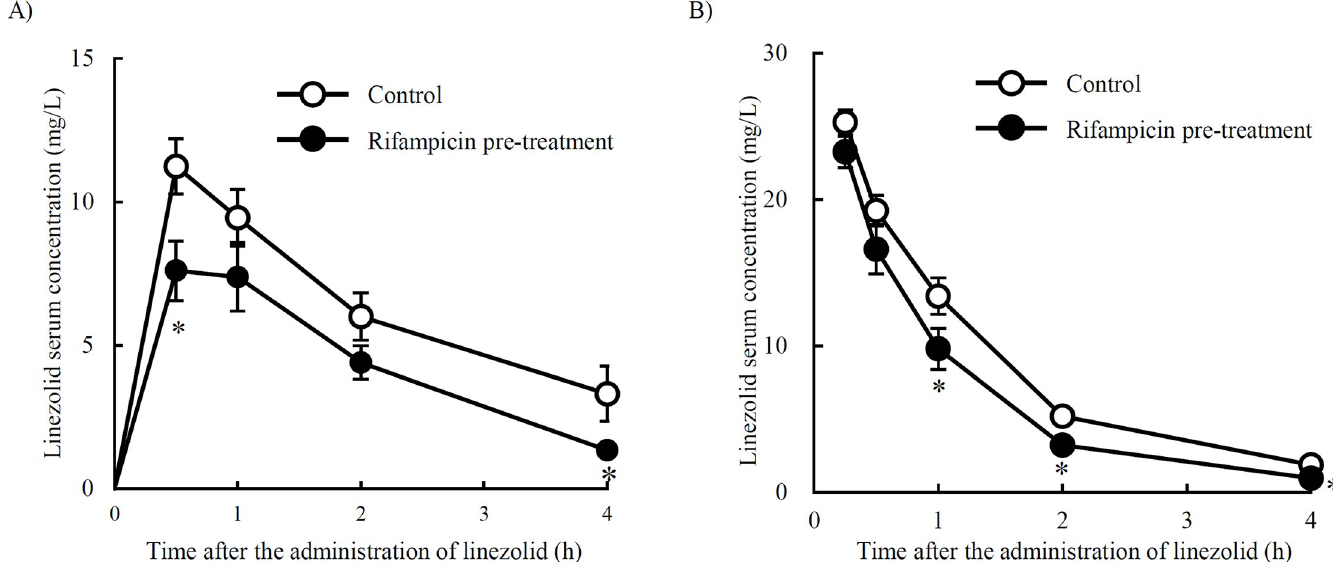
Fig 1. Effects of the rifampicin pre-treatment on the pharmacokinetics of linezolid. (A) Linezolid (25 mg/kg) was orally administered to mice (Control group). Mice were orally administered rifampicin (100 mg/kg) for 7 days. One day after the rifampicin pre-treatment, linezolid (25 mg/kg) was orally administered to mice (Rifampicin pre-treatment group). (B) Linezolid (25 mg/kg) was intravenously administered to mice (Control group). Mice were orally administered rifampicin (100 mg/kg) for 7 days. One day after the rifampicin pre-treatment, linezolid (25 mg/kg) was intravenously administered to mice (Rifampicin pre-treatment group). � P < 0.05 (unpaired t -test). Data are represented as the mean ± S.D. (n = 3 for each group).